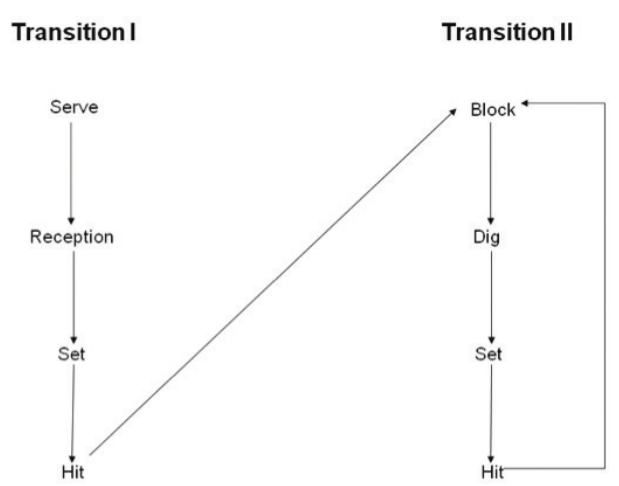
Figure 1. Transition I (attack) and Transition II (counter-attack) pro- cesses in volleyball